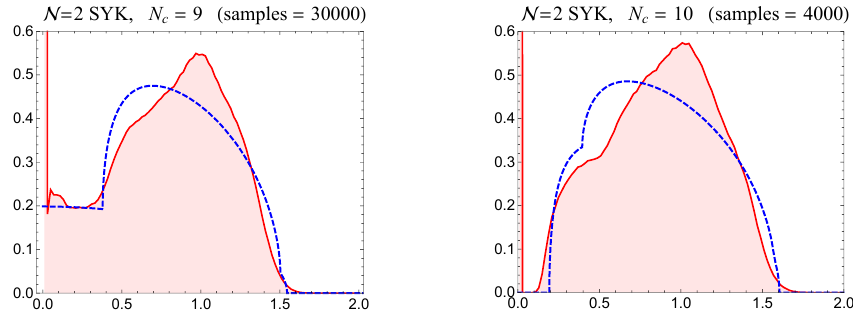
Figure 9 . Spectral density of M = Q + Q in the N = 2 SYK model from exact diagonalization for N c = 9 and 10, averaged over random samples. Since the spectra are symmetric about 0, only the nonnegative part is shown. The delta peaks at the origin represent exact zero modes, as in (cid:12)gure 6. In both plots J = 1 and the total density is normalized to 1. The blue dashed lines are the best (cid:12)ts of analytic approximations based on the Mar(cid:20)cenko-Pastur